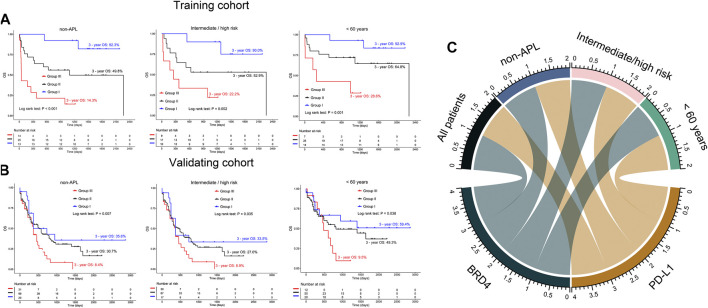
Subgroup analysis on co-expression of BRD4 and PD-L1 in predicting poor OS of AML patients. (A,B) Kaplan-Meier curves are shown for non-APL patients (left panel), intermediate/high risk (middle panel), and patients under 60 years old (right panel) according to the co-expression status of BRD4 and PD-L1 in the training (A) and validating (B) cohorts. (C) Summary chart of co-expression of BRD4 and PD-L1 for predicting OS in subgroups of AML patients. Group I: BRD4lowPD-L1low; Group II: BRD4highPD-L1low or BRD4lowPD-L1high; Group III: BRD4highPD-L1high.